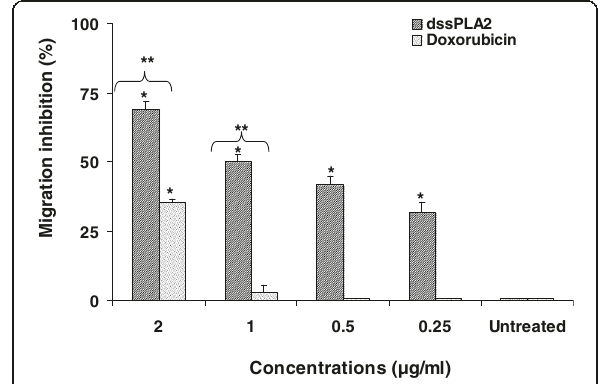
Fig 4 Inhibition of SK-MEL-28 cell migration by dssPLA 2 from Daboia siamensis venom compared with doxorubicin (anticancer drug) for 24 h. Results are expressed as mean±SE ( n =4). Significant differences between untreated and treated cells are presented as * p <0.001. ** p <0.001 indicates significant differences between dssPLA 2 and doxorubicin at the same